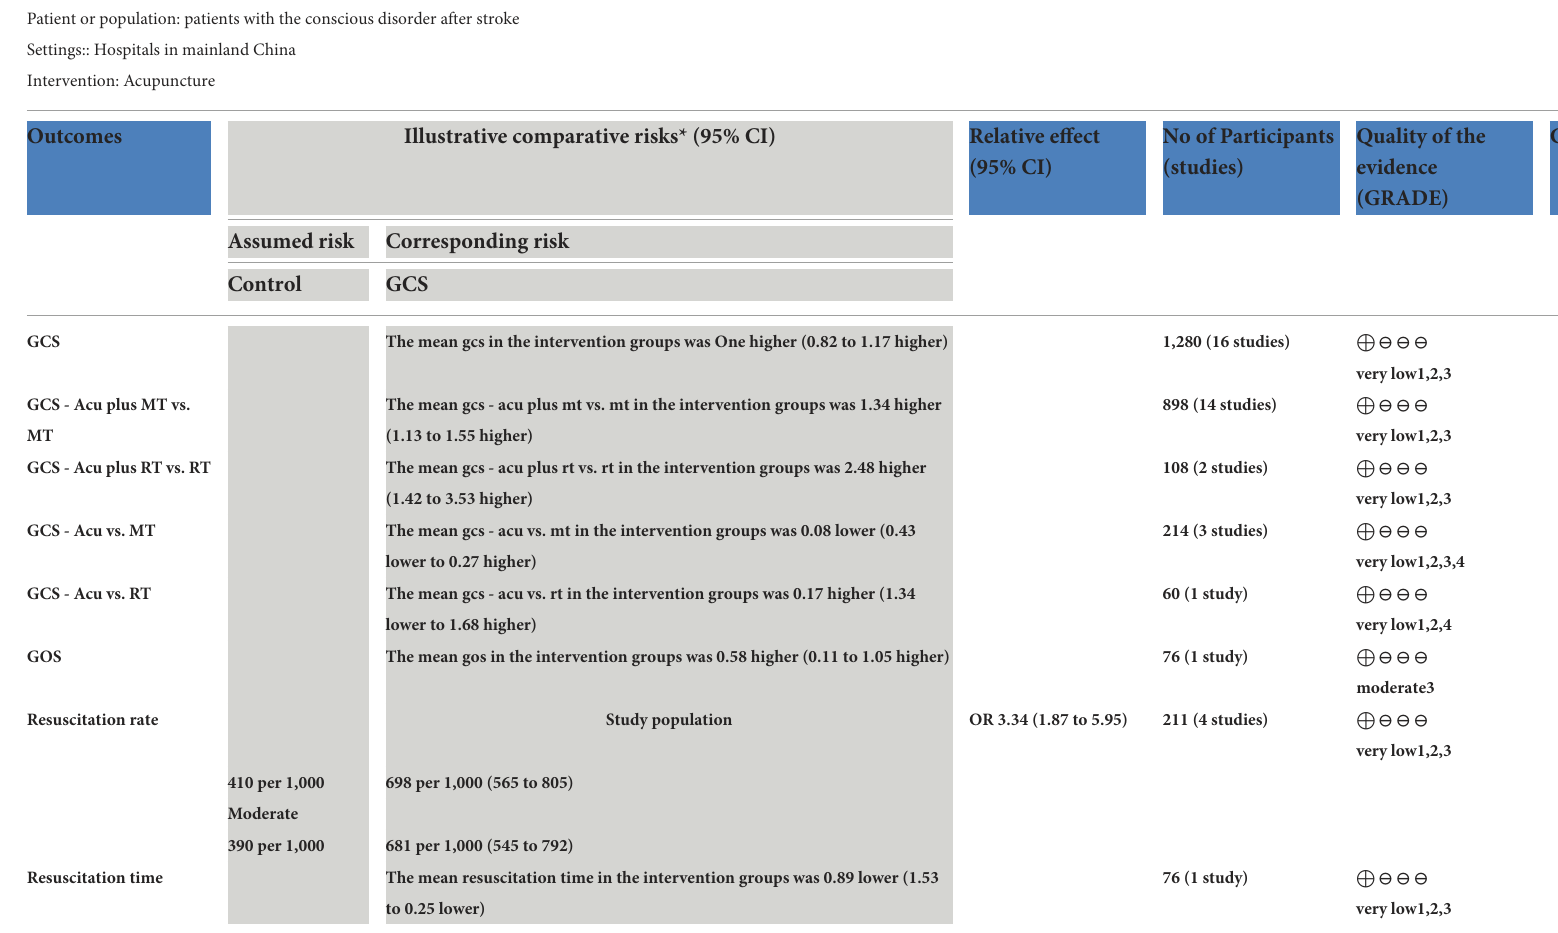
TABLE 3 Summary of findings and strength of evidence for